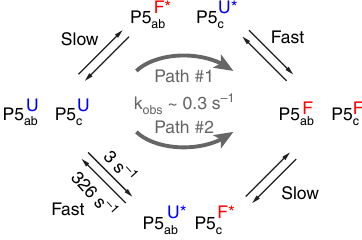
Figure 7 | Proposed tertiary folding pathways for tP5abc involving independent P5c switching. The ‘U’ and ‘F’ superscript represents unfolded and folded species, respectively. The ‘*’ shown for the intermediates indicates that the structure of P5abc or P5c in the intermediate may differ slightly from their corresponding fully unfolded or folded forms. Rate constants of the fast step in path #2 were derived from the R 1 r data in the presence of 1mM Mg 2 þ at 10 (cid:2) C (see Fig. 2c). The overall k obs for folding is obtained from a prior study 40 in the presence of 0.5mM Mg 2 þ at 10 (cid:2)